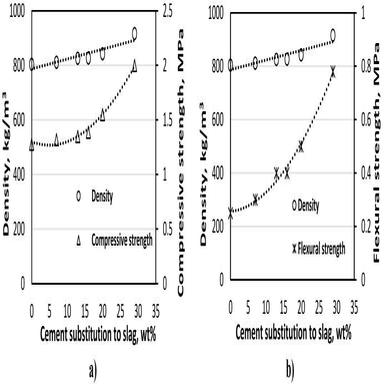
Density values and mechanical properties: a) compressive strength, b) Flexural strength of geopolymer pastes in function of different % cement substitutions to slag at S/L: 3.5 g/mL, 8 M KOH, 0.15 wt % Al powder & 70 ◦C curing temperature.